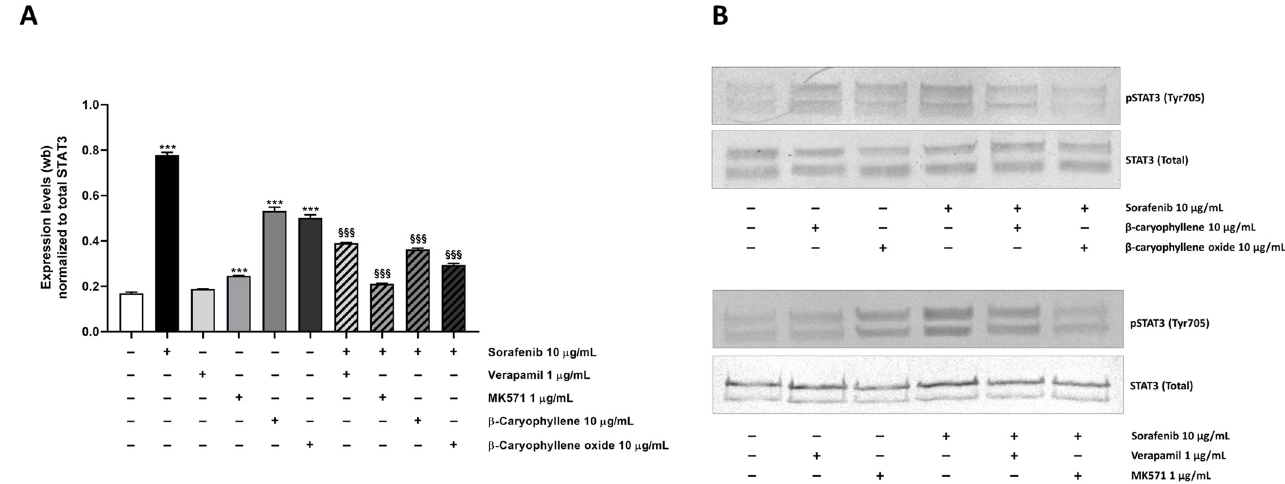
Figure 12. Effect of sorafenib, caryophyllane sesquiterpenes, verapamil, MK571, and their combination on the expression levels of phosphorylated STAT3 on tyrosine 705 residue in Bx-PC3 cells after 4 h exposure and 72 h recovery time. ( A ) Densitometric bar graph analysis (data expressed as mean ± standard error obtained from at least two independent experiments). ( B ) Representative Western blotting images, displaying phospho(Tyr705) STAT3 and total STAT3 (protein loading control). *** p < 0.001 (one-way ANOVA followed by Dunnett’s multiple comparison post-test) vs. control. §§§ p < 0.001 (one-way ANOVA followed by Dunnett’s multiple comparison post-test) vs. sorafenib.